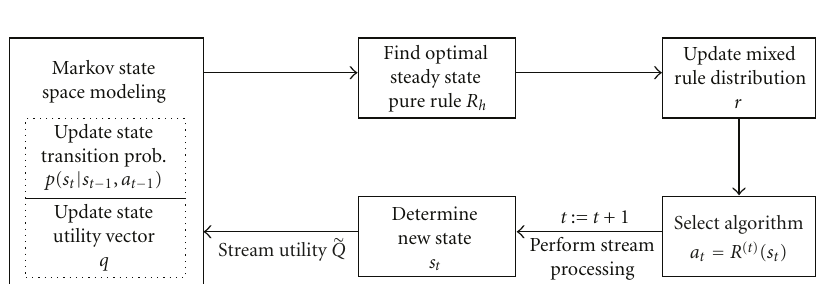
Figure 5: Flow diagram for updating parameters in Algorithm